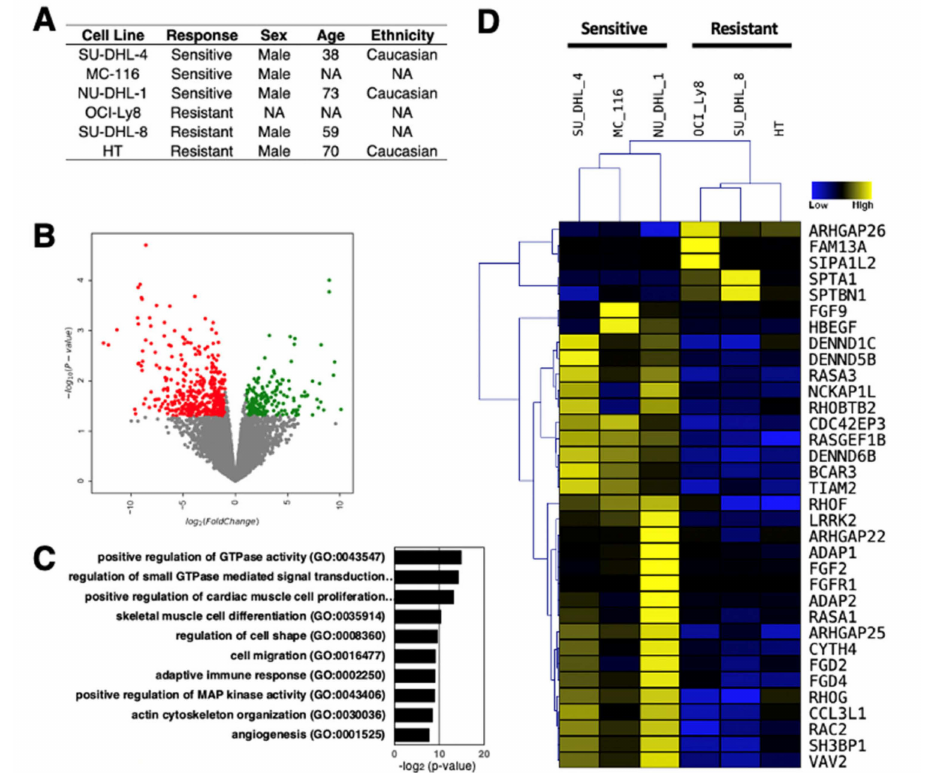
Figure 2. RNA-seq analysis of three rituximab-resistant and three rituximab-sensitive DLBCL cell lines. ( A ) Sample information for the DLBCL cell lines used in this study [95,96]. ( B ) Volcano plot of RNA-seq data. With the threshold values of 2-fold and p < 0.05, there are 195 up- and 428 down-regulated genes in rituximab-resistant compared to rituximab-sensitive DLCBL cell lines (n = 3 biologically independent samples). ( C ) Gene ontology (GO) of differentially expressed genes (both up- and down-regulated genes combined). ( D ) Hierarchical clustering of differentially expressed genes involved in GTPase signaling